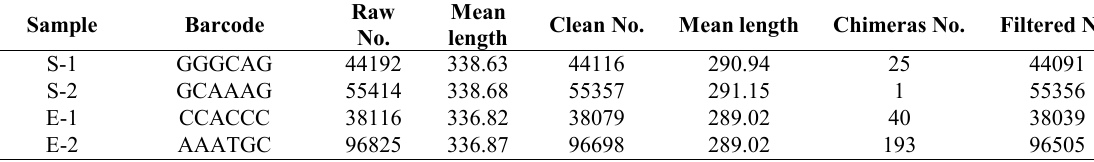
Table 1. Symbiodinium ITS2 gene sequencing data statistics. Sample